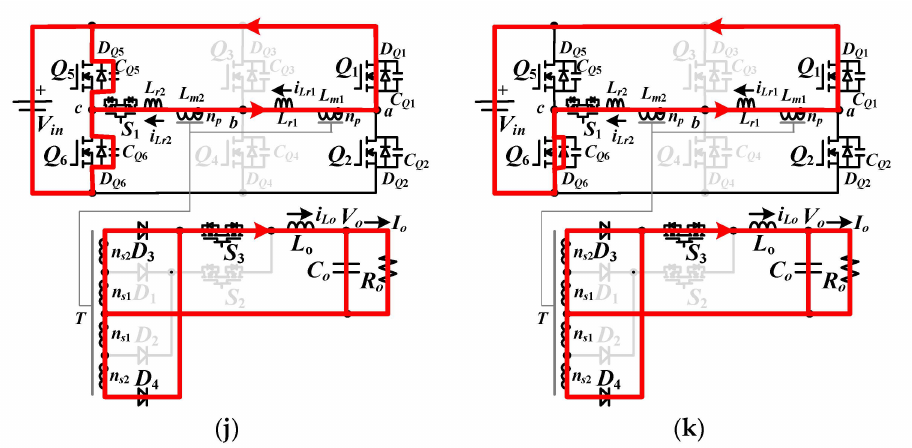
Figure 4. PWM waveforms and equivalent circuits at medium voltage range operation: ( a )